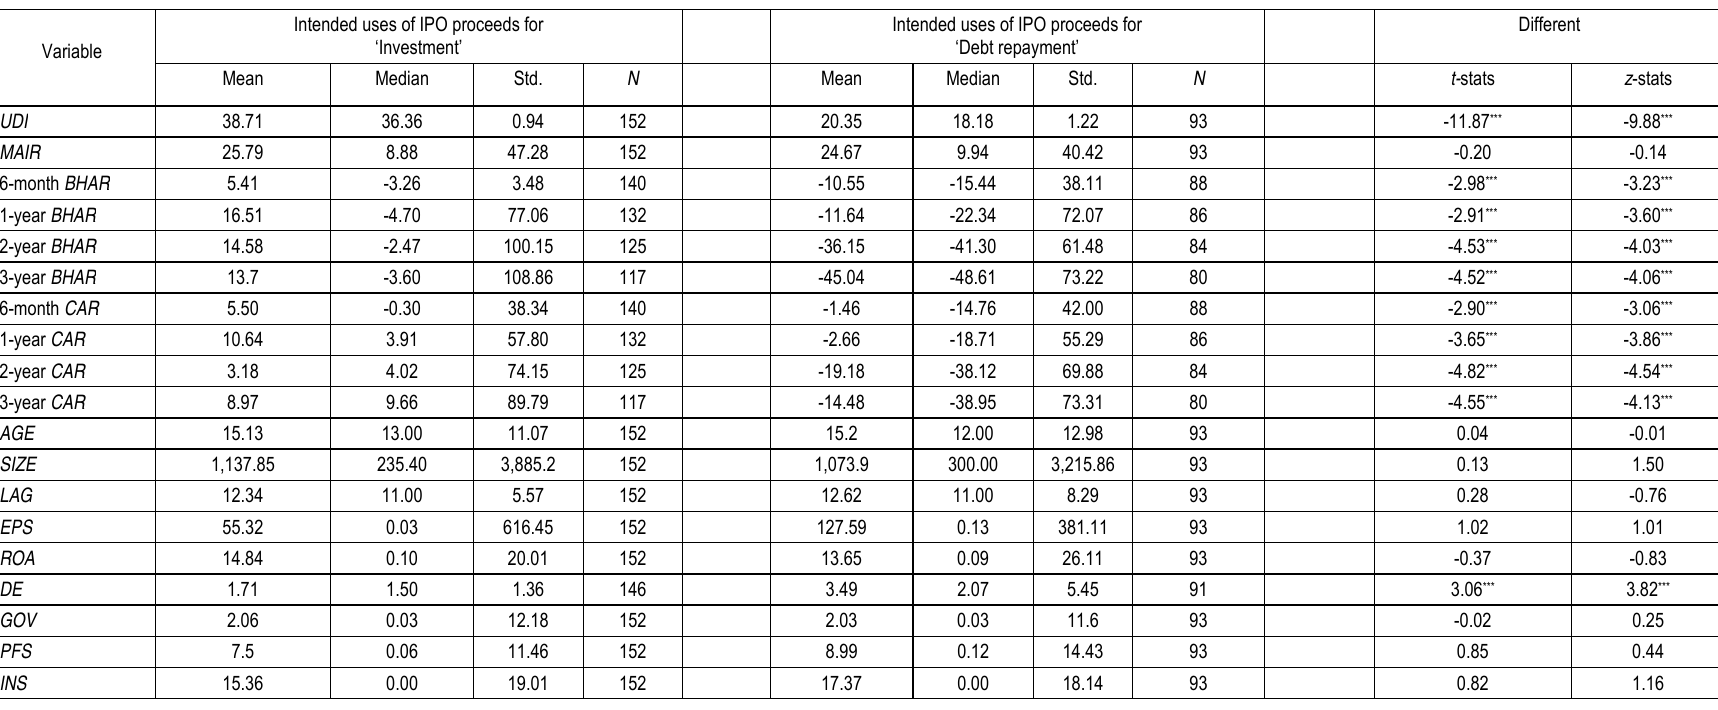
Table 5. Descriptive Statistics of the Main